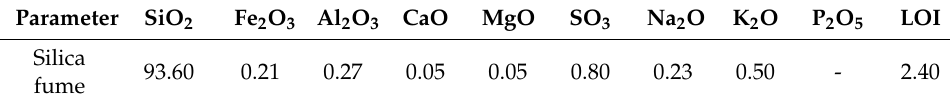
Table 9. Chemical composition of silica fume expressed in weight percentages